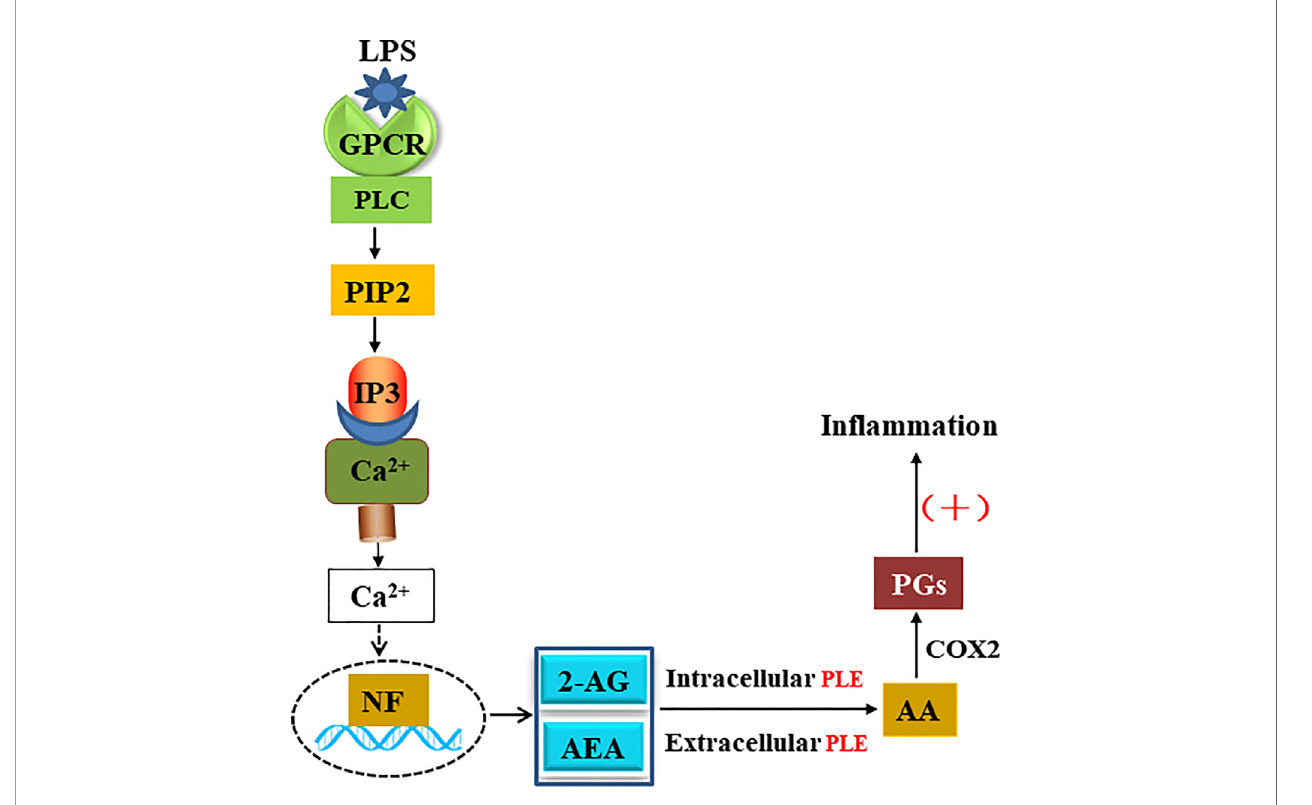
FIGURE 8 | Function of PLEs in eCBs metabolism and in fl ammatory